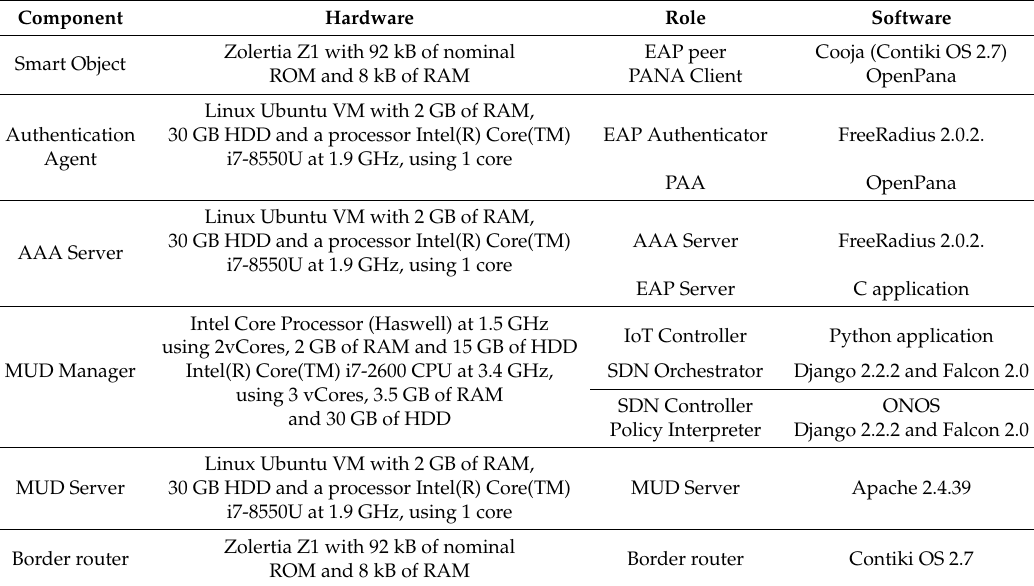
Table 2. Testbed